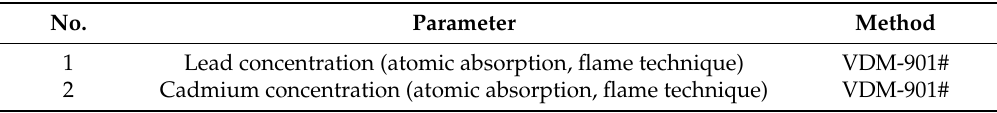
Table 1. Applied analytical methods for lead and cadmium